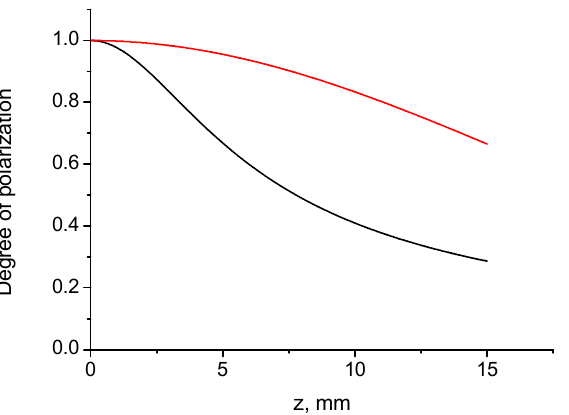
Figure 4. Degree of polarization as function of distance. Gaussian beam (black line), a 0 = 30 µ m; BG beam (red line), w 0 = 200 µ m, w B = 40 µ m.